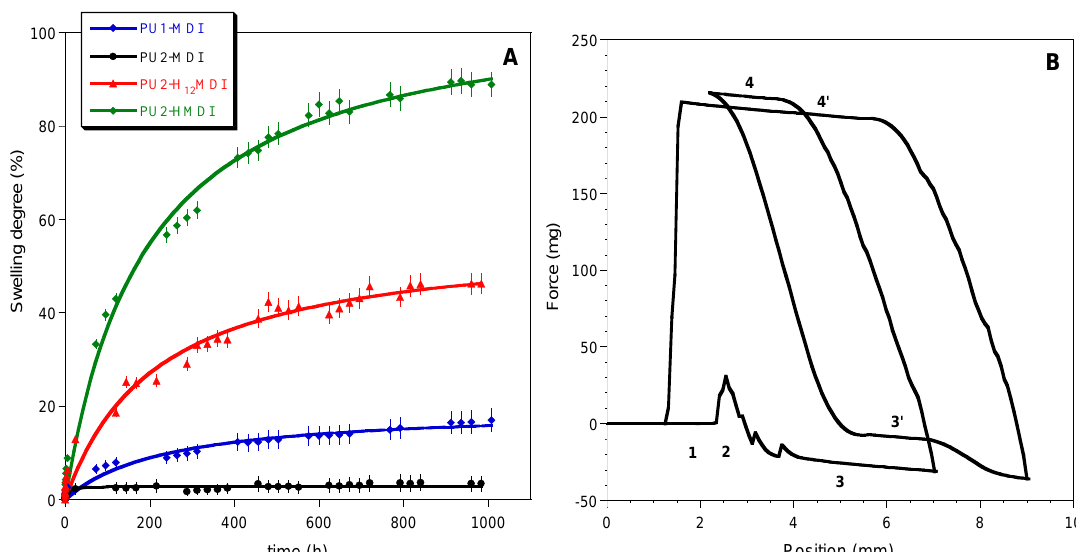
Figure 6. Curves of swelling in water ( A ); dynamic contact angle cycles of immersion for PU1-MDI when using the Wilhelmy plate method ( B ). In figure B, numbers 1 to 4 indicate the position of the plate with respect to the liquid: 1—Out of the liquid; 2—Point of touch of the sample with the liquid; 3—Immersion into the liquid ( θ adv I cycle); 4—Emersion from the liquid ( θ rec I cycle); 3’—Immersion into the liquid ( θ adv II cycle); 4’—Emersion from the liquid ( θ rec II cycle).